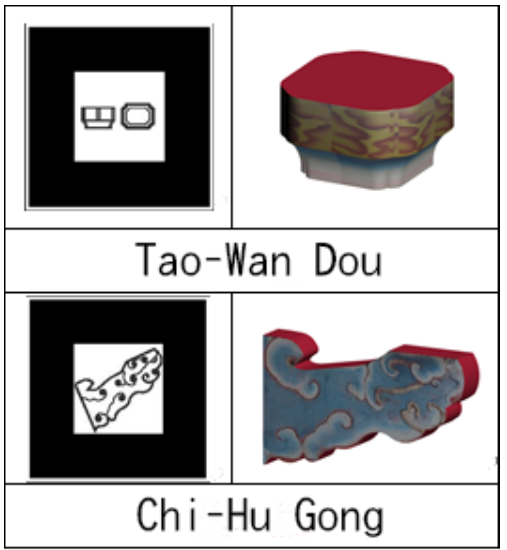
Figure 14. Tao-Wan Dou and Chi-Hu Gong